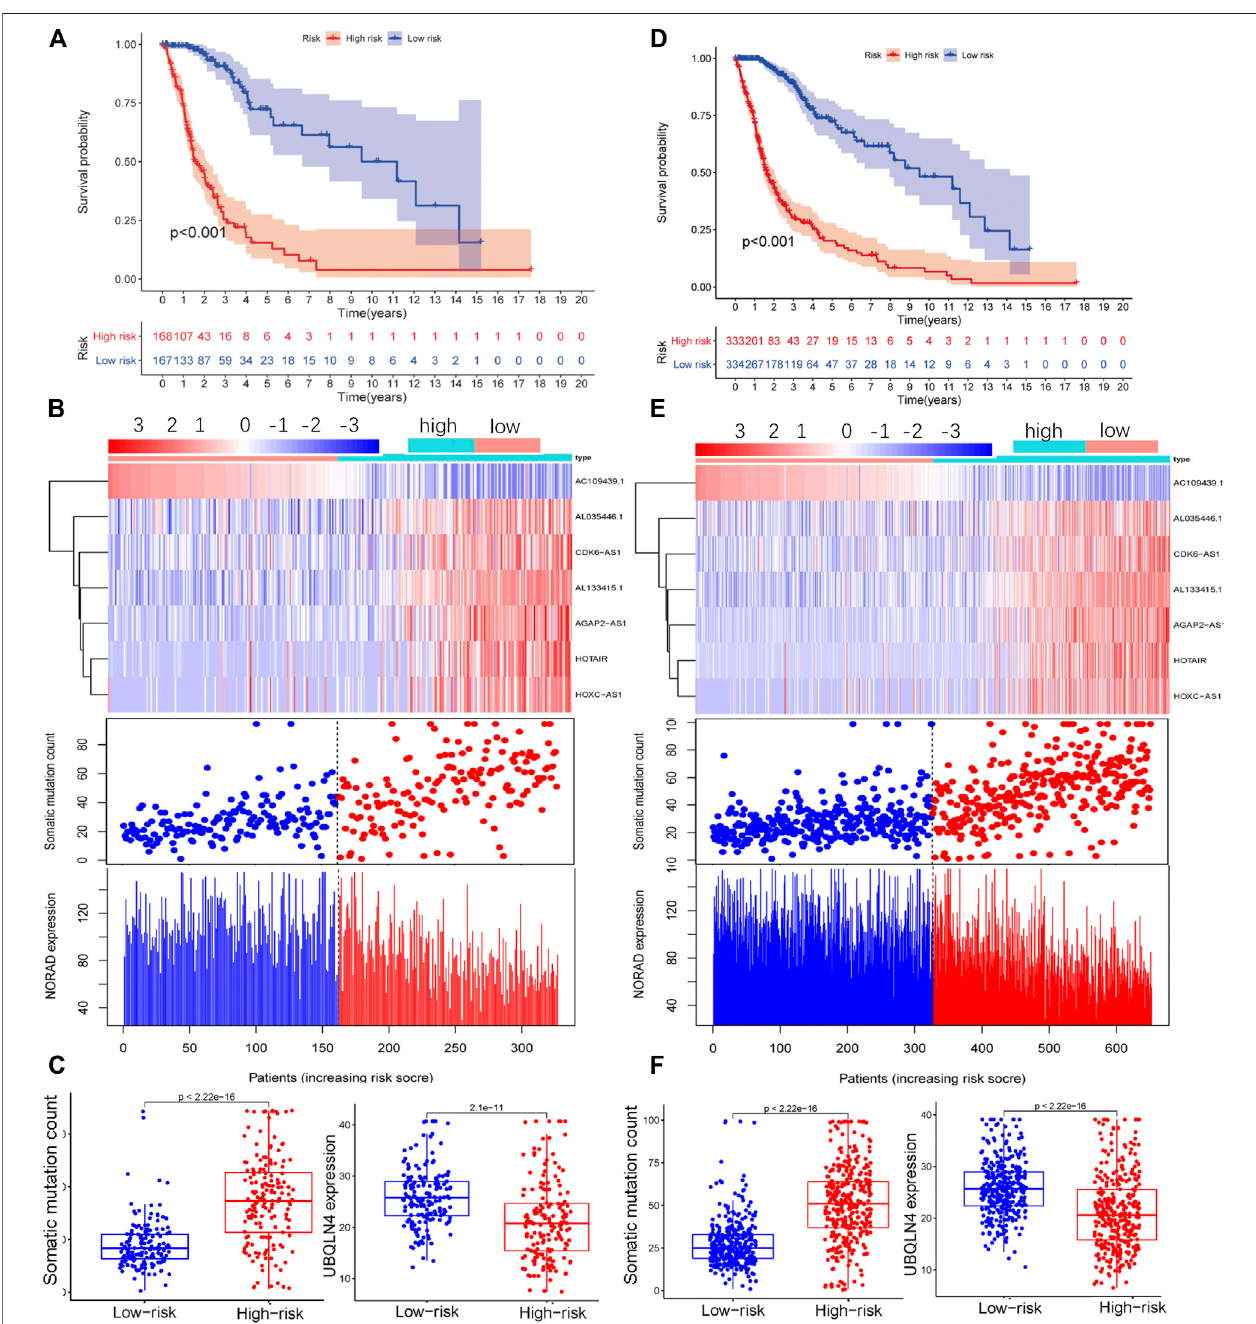
FIGURE3| PerformanceofGILncSig wasveri fi edusingthetestgroup(Test)and TCGAdata.Survivalcurvesofpatients inthehigh-and low-riskgroupsbased on the GILncSig score of the Test group (A) and TCGA (D) datasets. LncRNA expression patterns and distribution of somatic mutations and NORAD expression with increasing GILncSig scores in the Test group (B) and TCGA dataset (E) . Distribution ofcumulative somatic mutations and UBQLN4 expression in the high- and low-risk groups for glioma based on the Test group (C) and TCGA dataset (F) .